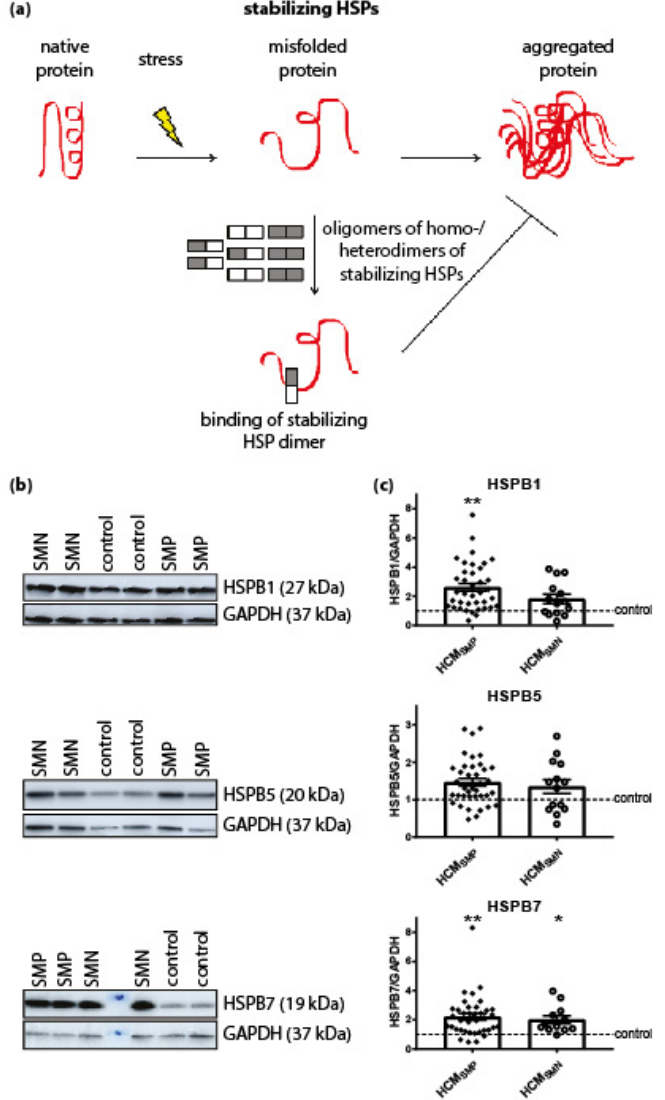
Figure 1. Stabilizing HSPs. ( a ) Under stress conditions when native proteins are destabilized and begin to unfold, stabilizing HSPs dissociate from homo- and/or heterogeneous oligomeric complexes into dimers to bind these partially misfolded proteins. Thereby, stabilizing HSPs prevent the aggregation of misfolded proteins. Figure reproduced and adapted with permission from Dorsch, L.M. et al., Pflügers Archiv–European Journal of Physiology; published by Springer Berlin Heidelberg, 2018. ( b ) Representative blot images for HSPB1, HSPB5, and HSPB7 expression. ( c ) Higher levels of HSPB1 and HSPB7 in HCM SMP ( n = 38) compared to controls. Higher HSPB7 levels in HCM SMN ( n = 12) compared to controls ( n = 9; average is shown as dotted line). HSPB1 and HSPB5 protein levels were not different in HCM SMP ( n = 14) compared to controls. There were no significant differences between HCM SMP and HCM SMN . Each dot in the scatter plots represents an individual sample. * p < 0.05 and ** p < 0.01 versus controls.